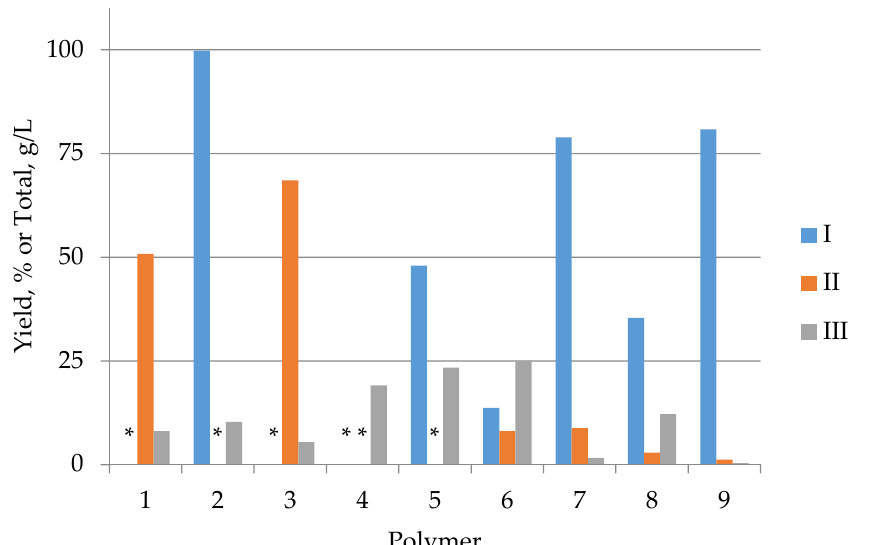
Figure 2. The results of polymer processing by the hydrothermal liquefaction: I—oil yield, %; II—Solid Phase Yield, %; III—Total Organic Carbon in the Aqueous Phase, g/L. Plymers: 1—Polybutylene terephthalate; 2—Polycarbonate; 3—PET; 4—Polylactate; 5—Polymethyl methacrylate; 6—Polyoxymethylene; 7—Polyphenylene oxide; 8—Polyvinyl acetate; 9—Styrene butadiene. *—no data.